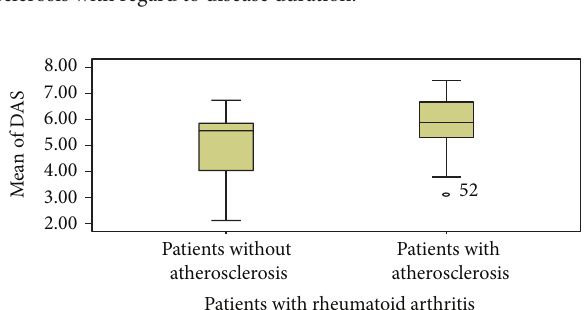
Figure 1: Comparison between patients with and without athero- sclerosis with regard to disease duration.